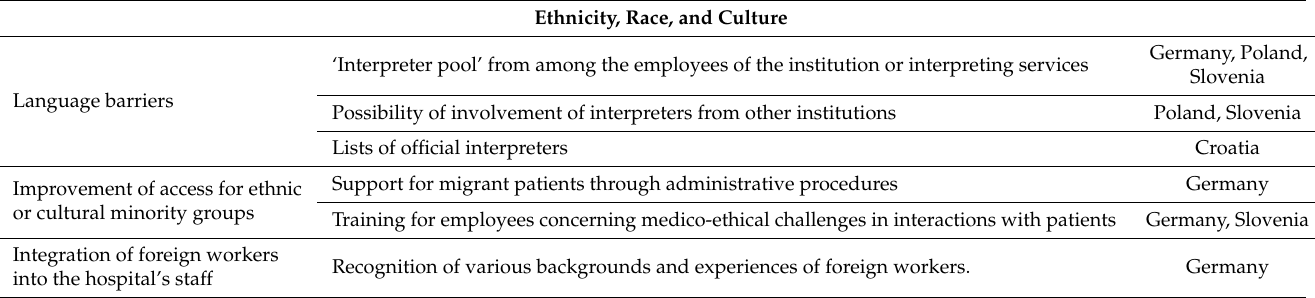
Table 3. Statements regarding ethnicity, race, and culture in hospitals internal documents in Croatia, Germany, Poland, and